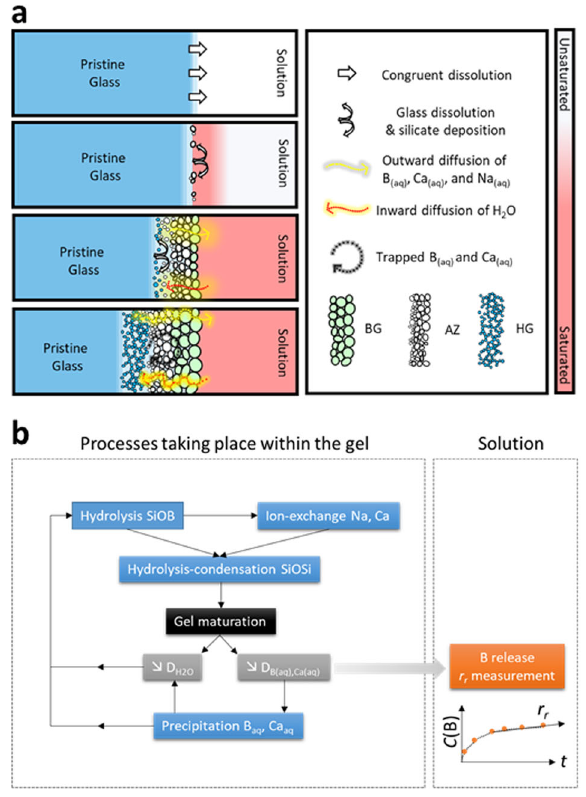
Fig. 6 Conceptualization of the mechanisms controlling the residual rate. a Schematic outline of the proposed glass corrosion model. The corrosion rate corresponds to derivate of the transfor- mation of the pristine material into alteration products (dissolved species, gel, secondary minerals) with respect to time. The residual rate regime starts when Si-saturation of the contacting solution is achieved. The restructuration of the gel which eventually leads to the formation of a diffusion barrier for water and dissolves species is intimately tied to the release of mobile elements from the glass structure. b Interplay between the mechanisms involved in the residual rate